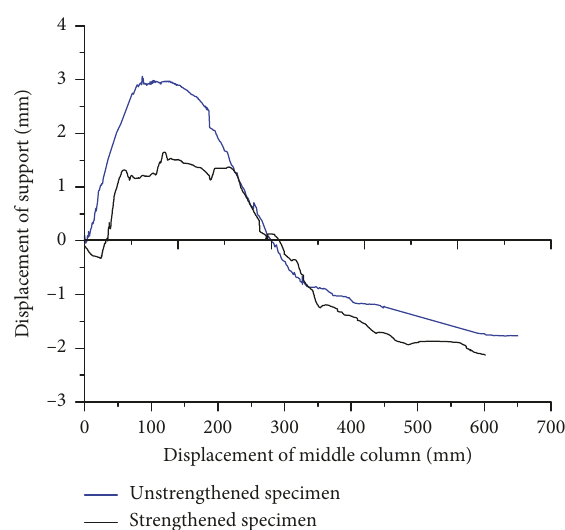
Figure 11: Relationship between lateral displacement of the side column and vertical displacement of the middle column.